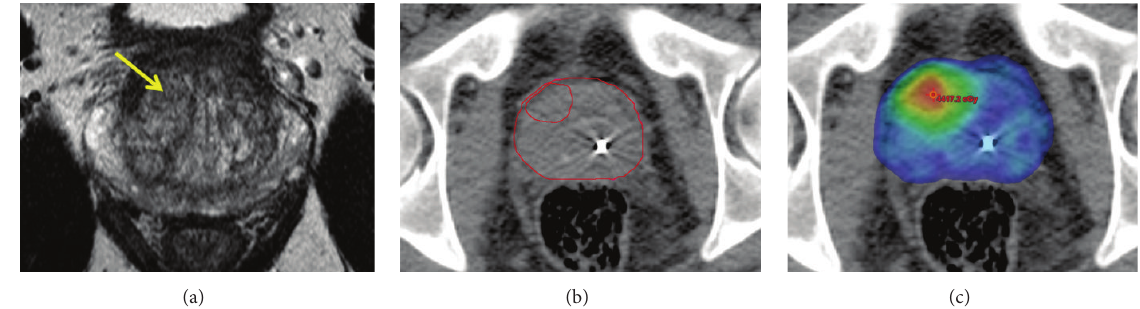
Figure 2: Axial views of the patient in Figure 1 with Gleason 3 + 4 disease found in right mid anterior central gland using MRI-TRUS fusion biopsy. The T2 hypointense lesion is shown in (a) with clinical target volumes drawn around the prostate and nodule on axial CT in (b). A 36Gy dose colorwash to the whole prostate and simultaneous integrated boost of 40Gy to the T2 hypointense lesion using an extreme hypofractionation radiation treatment plan are shown in (c). Note the fiducial markers used for daily image-guided